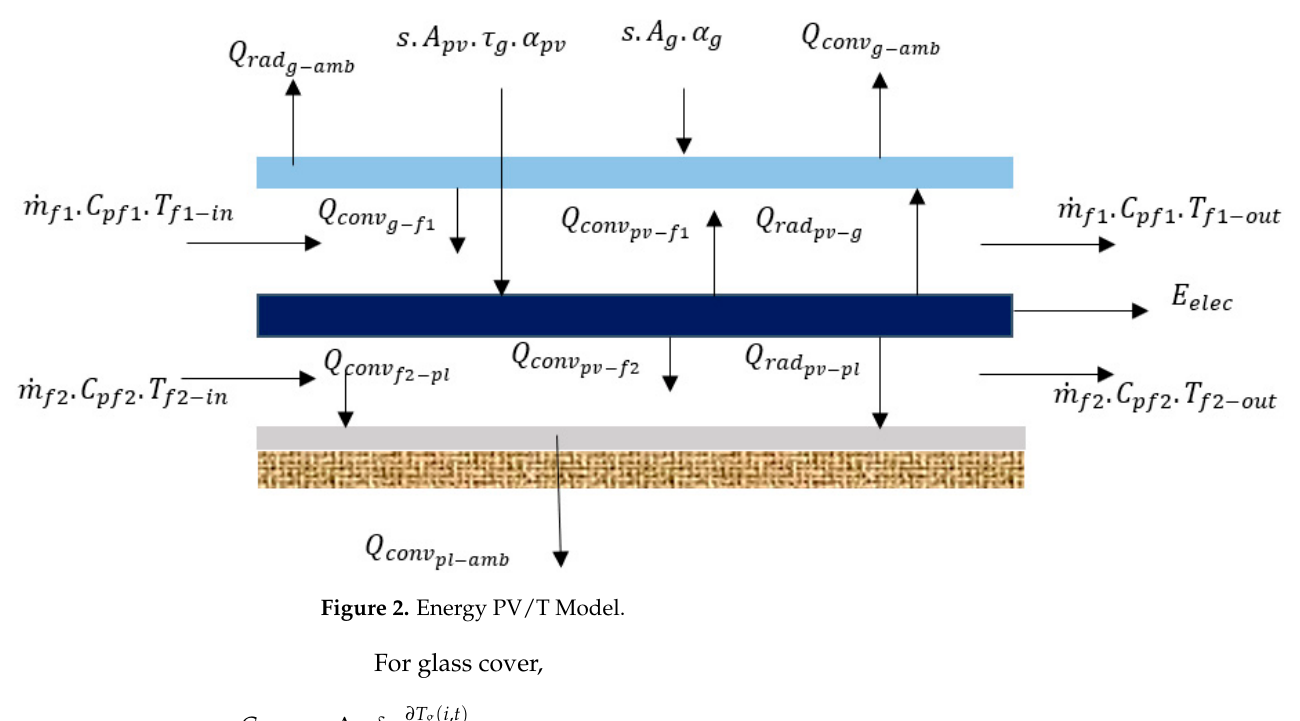
Figure 2. Energy PV/T